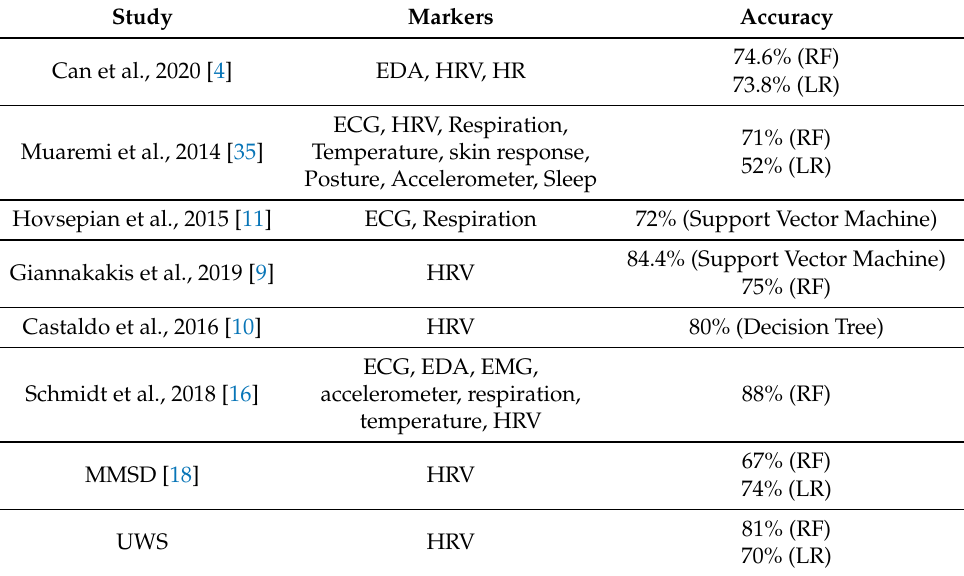
Table 6. Summary of ML models used for stress detection through physiological